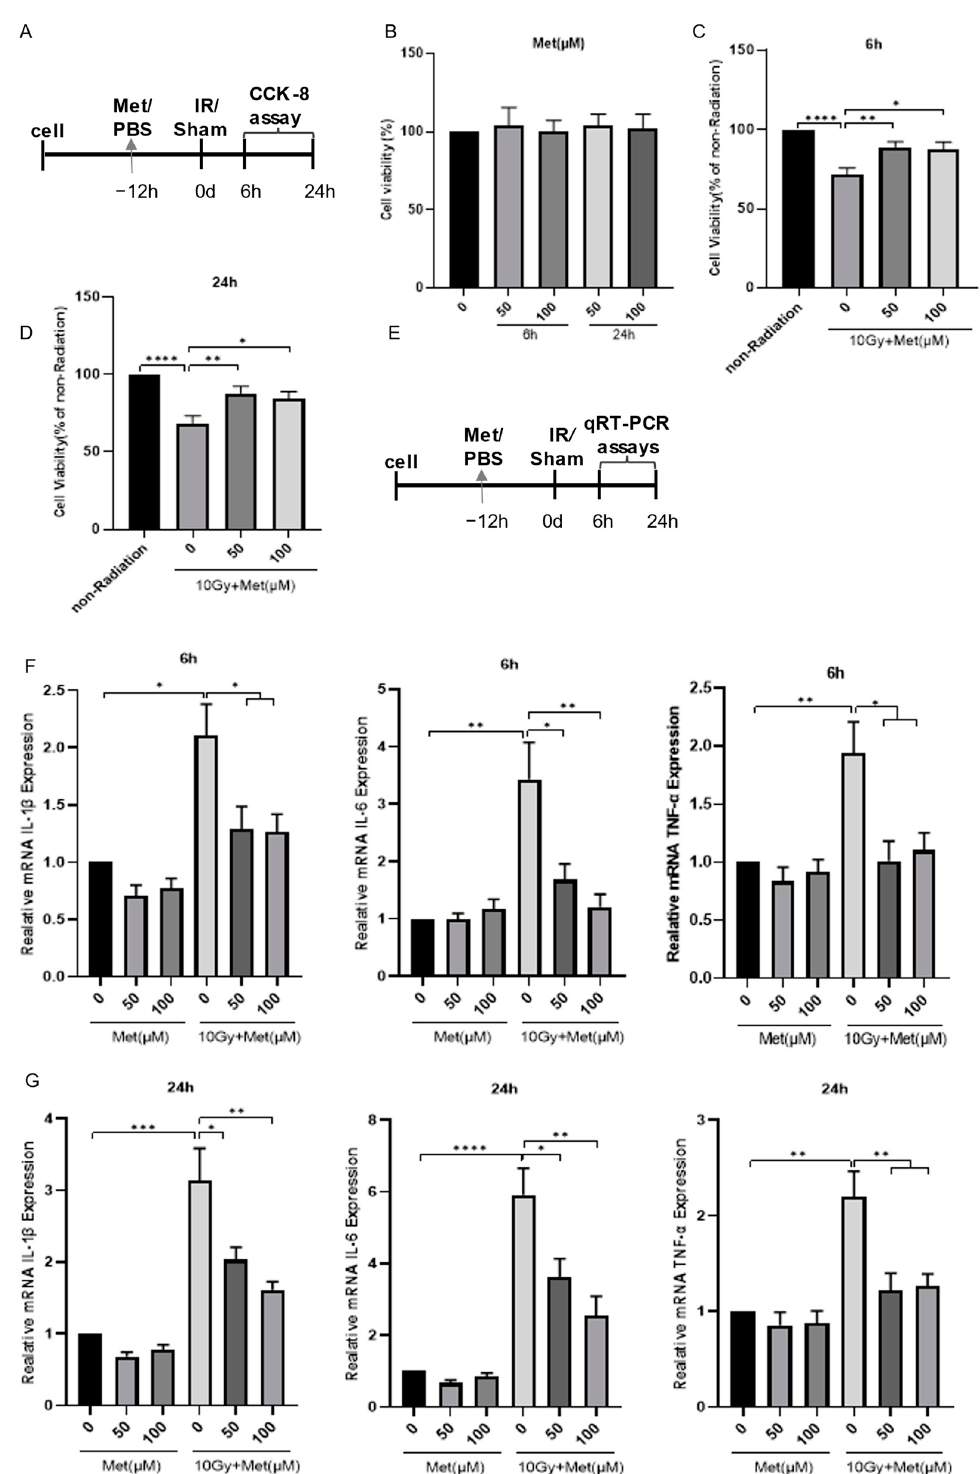
Figure 4. Metformin reduces radiation-induced inflammation in BV2 cells. ( A ) Overview of the CCK-8 assay timeline. Met, metformin; PBS, phosphate buffer solution; IR, irradiation; h, hour. ( B ) The e ff ect of metformin on the viability of BV2 cells was detected by CCK-8 assays. ( C , D ) The e ff ect of metformin on the proliferation viability of BV2 cells was detected by CCK-8 assays 6 ( C ) and 24 h ( D ) after 10 Gy irradiation. ( E ) Schematic diagram of the in vitro irradiation model (10 Gy). ( F , G ) The mRNA expression levels of IL-1 β , TNF- α and IL-6 at the 6th ( F ) and the 24th h ( G ) after irradiation. * p < 0.05, ** p < 0.01, *** p < 0.001, **** p < 0.0001.